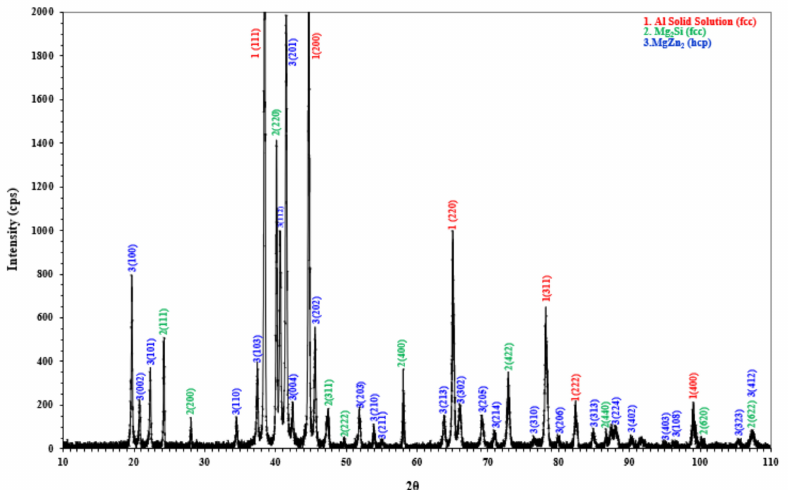
Figure 11. X-ray diffraction pattern of 1MH’